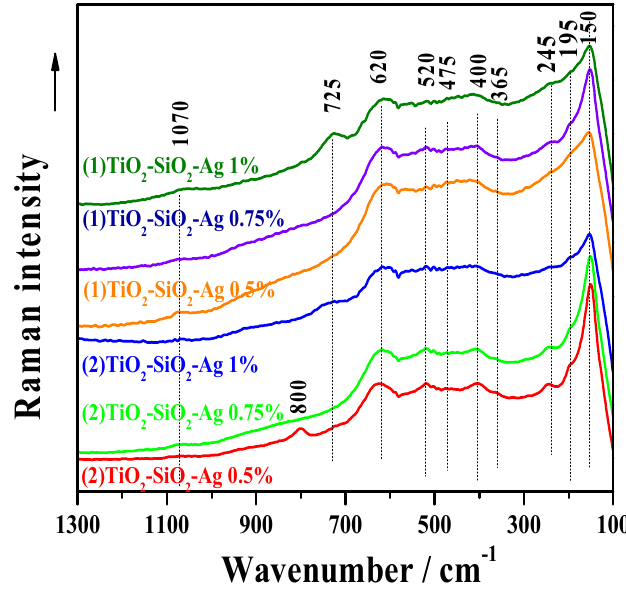
Figure 4. Crystallinity related aspects investigated by Raman